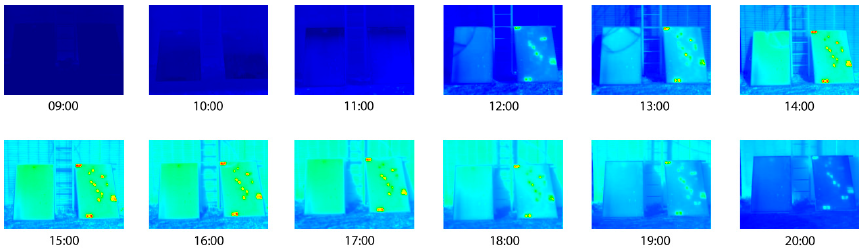
Figure 3. Thermographic monitoring of PV panels. The color palette applied is the same as in Figure 2 (from 0 to 60 °C).